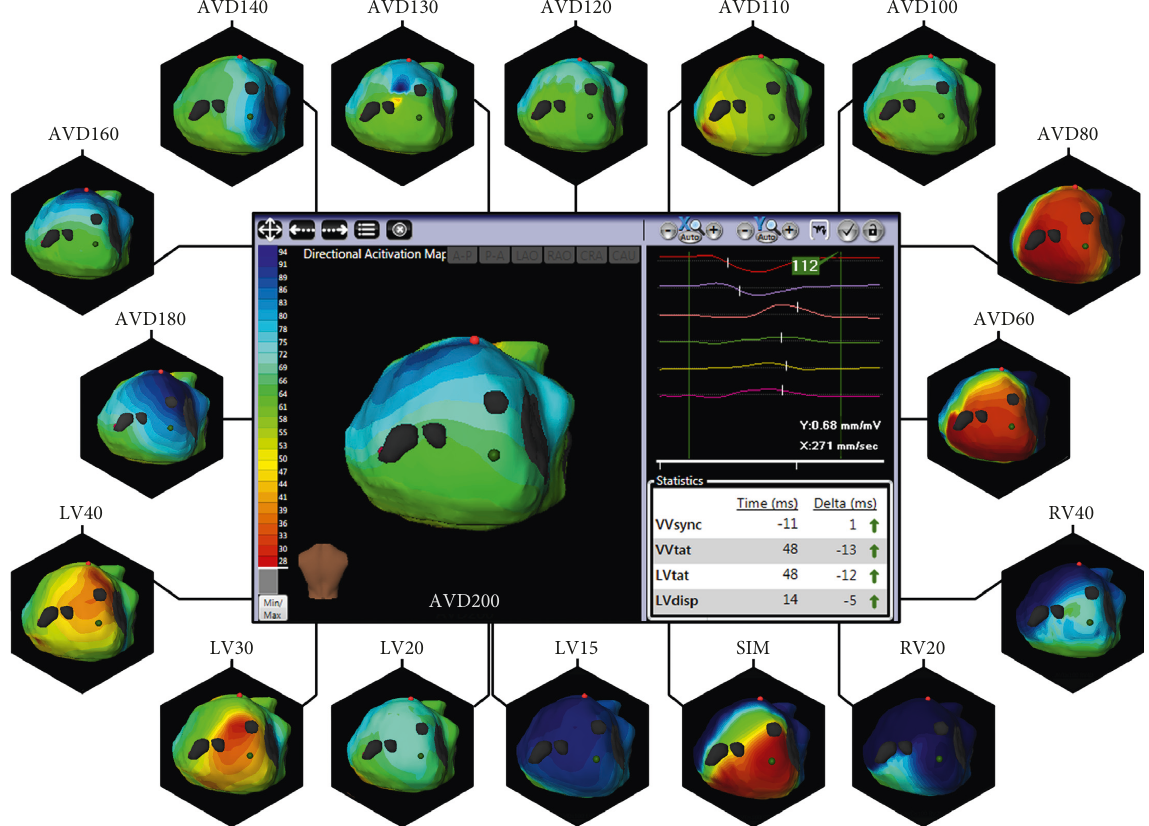
Figure 1: Example of 3D epicardial isochrone maps obtained for patient 7 during CRT optimisation where the optimal atrioventricular delay (AVD) and VV were identified through echo-guided optimisation. Table 1: Patient characteristics. Table 2: Baseline ventricular activation times.